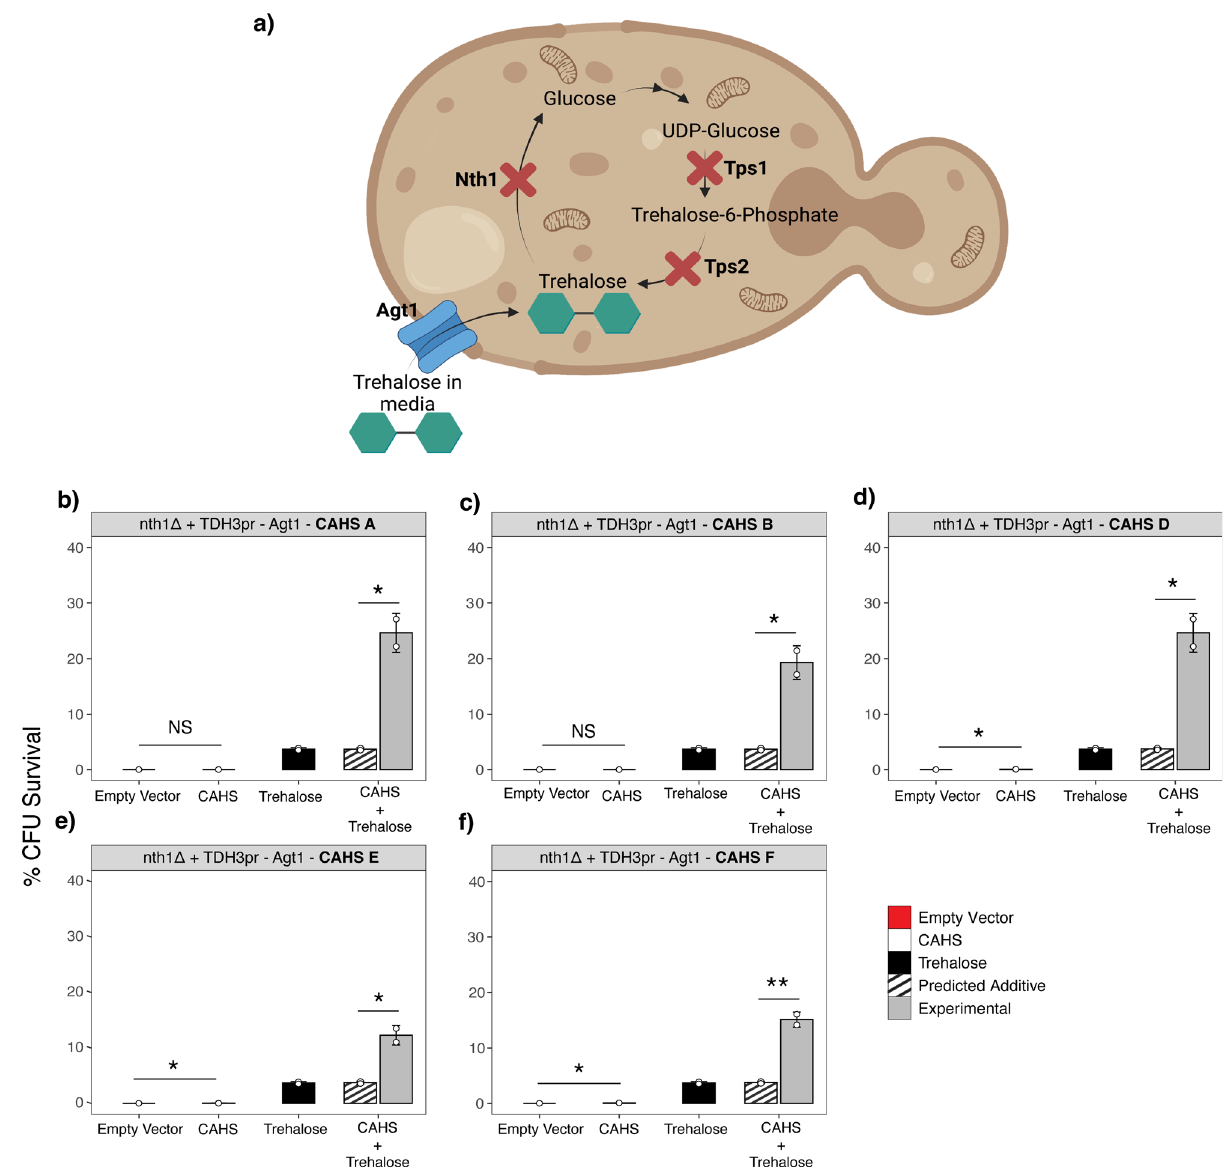
Fig. 5 In vivo yeast synergy assay. a Yeast strain nth1 Δ + TDH3pr-Agt1 was constructed to have a knockout of Nth1 which encodes trehalase for trehalose breakdown, and the addition of an intracellular trehalose transporter, AGT1. Yeast grown in log phase do not express Tps1 or Tps2. b – f nth1 Δ + TDH3pr- Agt1 yeast strains expressing different CAHS genes with and without supplemented trehalose were assayed for survivability against desiccation stress. One way ANOVA was used for statistical comparisons where *** indicates p -value < 0.001, error bars = standard